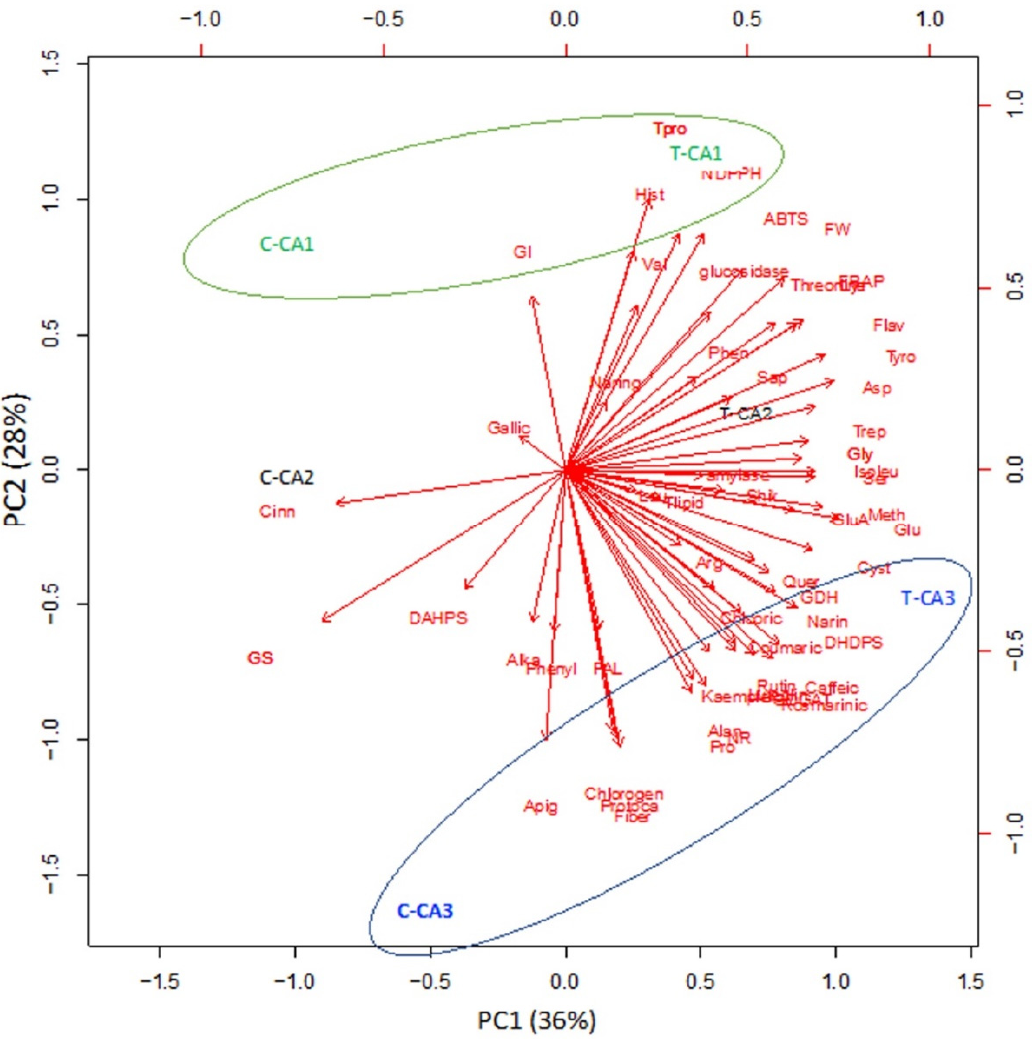
Figure 5. Principle component analysis (PCA) of 3 Canavalia species after seed priming with molybdenum (Mo). CA; Canavalia ensiformis var. gladiata , CA2; Canavalia ensiformis var. truncata Ricker , CA3; Canavalia gladiata var. alba Hisauc .